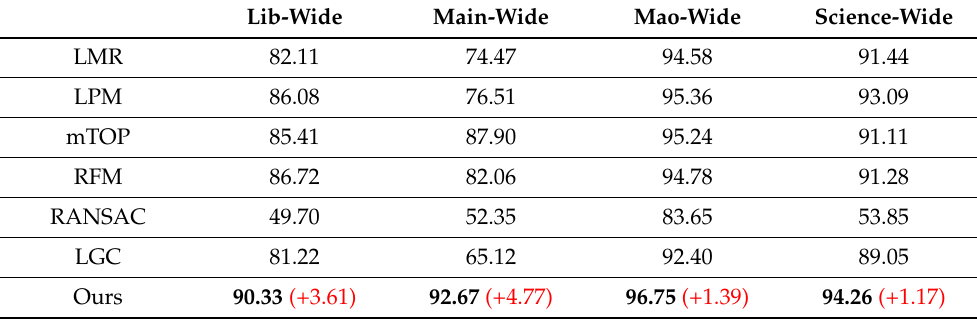
Table 6. The average F1-score (%) of four scenes from the NMNET dataset. The best results are in bold. The red numbers in the brackets indicate the improvement between the best and the second best